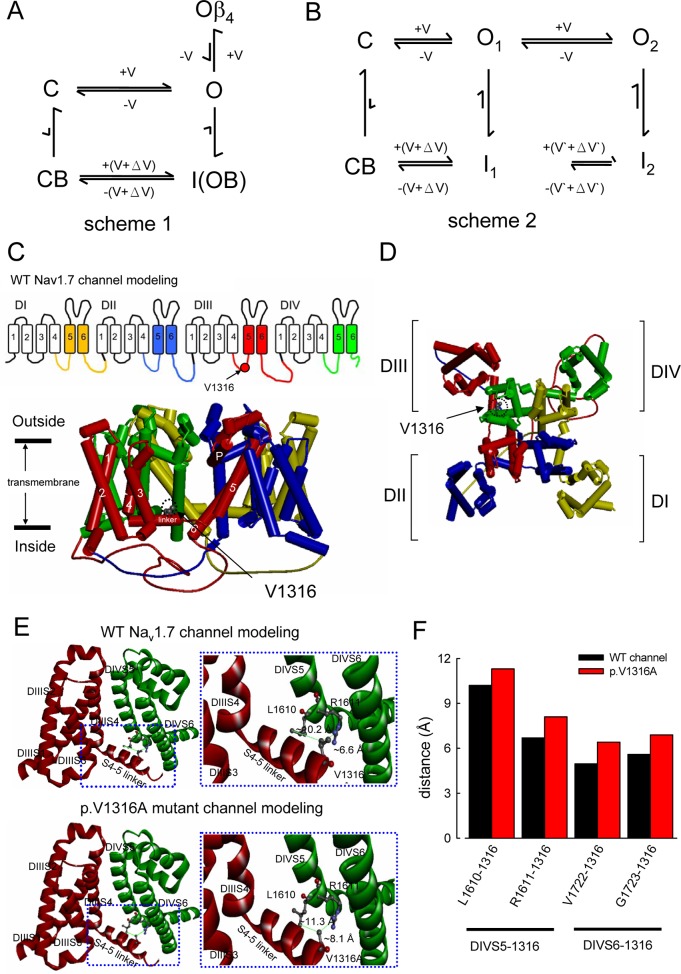
Gating schemes of the Nav1.7 channel and the genesis of the resurgent currents.(A) The conventional view of the action of the Navβ4 peptide on Na+ channel (scheme 1). C and O are the closed and open states, respectively. +V and–V (or +V’ and–V’) denote voltage-dependent rates accelerated by depolarization and hyperpolarization, respectively. The inactivation state (I) is virtually an open but blocked state (OB), the making of which is coupled to channel activation (C to O to I) because of the essentially negligible (the very slow) C to CB transition. The “+(V+ΔV)” and “–(V+ΔV)” indicate that the voltage dependence of the transitions between state OB (i.e., state I) and CB would be shifted by ΔV for the binding energy of the inactivating peptide. In the absence of Navβ4 peptide, the recovery of the inactivated channel would primarily take the I to CB to C route due to the very slow I to O transition, and thus result in no currents during the recovery process. The Navβ4 peptide is a pore blocker that competes with the inactivating peptide for the open channel pore. The Oβ4 is therefore also a blocked state allowing no current passage, but could only go through the open state to the closed state during hyperpolarization. The resurgent currents are thus generated at the repolarization phase following a depolarization. The size of the arrows in the scheme roughly denotes the relative rate of the transition. The rate from O to Oβ4 cannot be negligible compared to that from O to I for discernible resurgent currents to occur. (B) A new model for the genesis of resurgent currents (scheme 2). O1, O2, I1, and I2 are the first and second open and inactivated states, respectively. The Navβ4 peptide is primarily a gating modifier giving rise to the new gating states O2 and I2, rather than a pore blocker competing with the inactivating peptide. Upon a strong-enough depolarization, a sizable amount of channels in state O1 would quickly move to state O2 and then inactivated (state I2) because the O1 to O2 transition is very fast and no longer negligible compared to the O1 to I1 transition. The I2 to I1 transition is relatively slow so that the recovery from I2 upon repolarization would have a significant chance to take the I2 to O2 to O1 to C route and give rise to discernible resurgent currents. Moreover, although the steady-state occupancy in general favors I1 over I2 (the steady-state I1/I2 ratio is weakly voltage-dependent and is larger at +20 than at +60 mV, Figs 8 and 10), the redistribution from I2 to I1 is relatively slow and would take ~10 ms or longer to accomplish (Figs 8B and 10D). The recovery from state I1, on the other hand, would primarily go through the CB to C route because of the extremely slow rate from I1 to O1, and thus allows no resurgent currents. The resurgent current therefore is a transitional phenomenon, not only because state O2 is itself transient, but also because the inactivated state giving rise to O2 during recovery (i.e., I2) is also mostly transient (rather than an “end” state) at a fixed membrane depolarization. (C) The homology model is constructed based on X-ray crystal structures of Arcobacter butzleri voltage-gated Na+ channel (NavAb) of a closed-pore conformation using Discovery studio V3.0 software (see Material and Methods for more detail). Side view of the homology model of WT Nav1.7 channel shows the transmembrane part of the four domains. Domains I, II, III, and IV are colored yellow, blue, red, and green, respectively. Transmembrane segments (S1–S6) of domain III are highlighted. The side chain of V1316 in the S3–S4 linker of domain III is indicated in the ball and stick model. (D) A regional view of the homology model of WT Nav1.7 channel from the extracellular side of the pore. (E) Two domains (domain III and IV) of the homology model of WT Nav1.7 and p.V1316A mutant channels are shown in the ribbon presentation. The side chains of V1316 in the (S4–S5 linker/D3), L1610 and R1611 (both in S5/D4) are indicated with sticks and balls of different colors. An enlarged view of the boxed area is shown in the right panel, demonstrating inter-residue distances (from side chain tip to tip) of ~10.2 Å and ~6.6 Å between V1316 and L1610 and between V1316 and R1611, respectively, in the WT Nav1.7 channel. On the other hand, the inter-residue distances (from side chain tip to tip) between p.V1316A and L1610, and p.V1316A and R1611 are ~11.3 Å, ~8.1 Å, respectively, in the p.V1316A mutant channel. (F) A summary plot of the relative (tip to tip) distances between residues V1316 (or p.V1316A) and L1610, R1611, V1722, and G1723 in the homology modeling. Note the evidently increased distances in all cases in the p.V1316A mutant than in the WT channels (see also S2 Fig). Individual data is shown in the file of S1 Data.